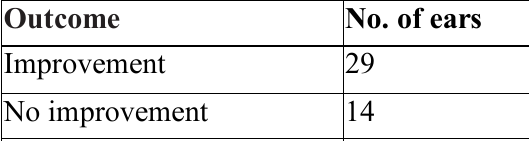
Table 6(c): Audiological results in successful cases-Air bone gap in pure tone audiometry